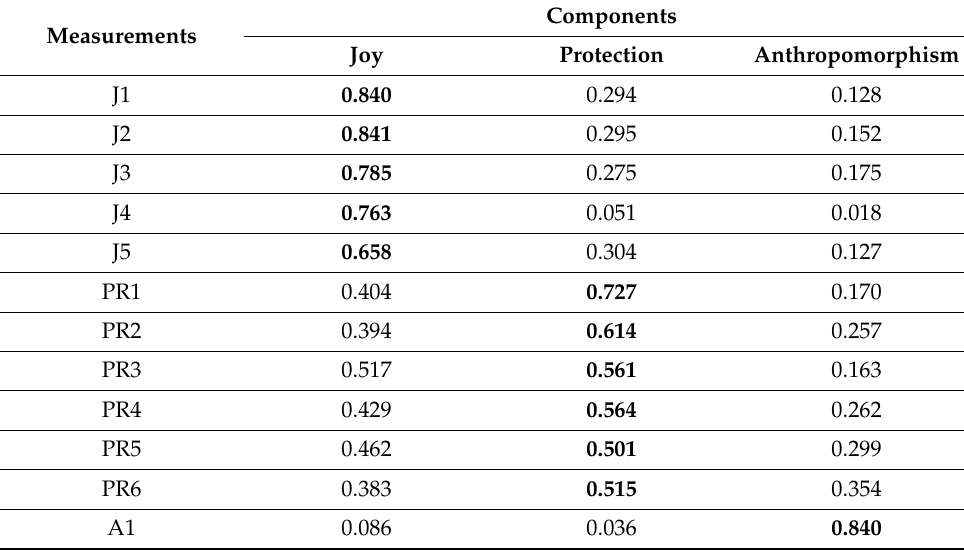
Table 2. EFA results of dimensions: varimax rotated loading